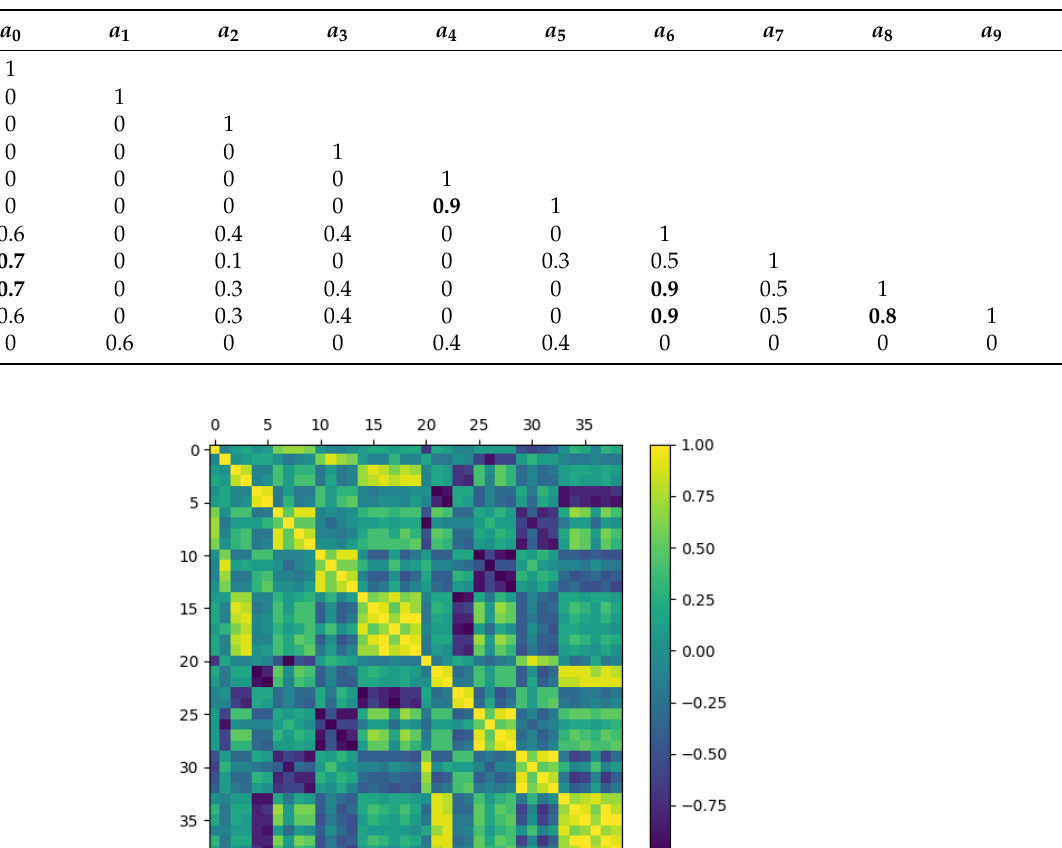
Table 3. Matrix of correlation coefficients between RPCs (only the correlation coefficients from a 0 to a 10 are listed here, and the detailed correlation coefficient matrix from a 0 to b 19 is shown in Appendix A, where bold indicates c ij > 0.7).